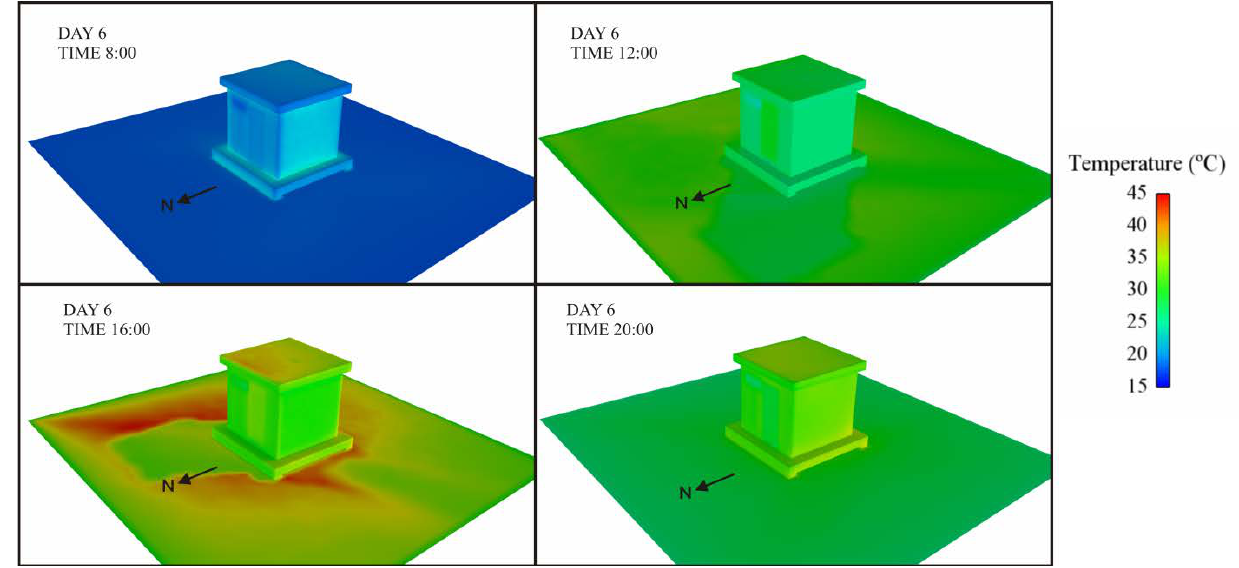
Figure 11. Evolution of the temperature field of the cubicle